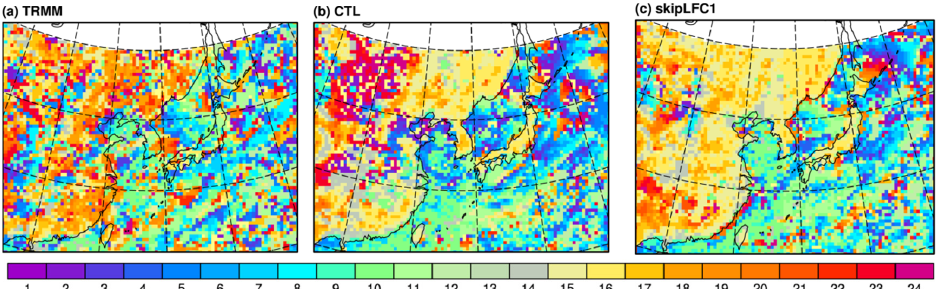
Figure 8. Spatial distribution of LST of daily maximum precipitation rate over East Asia averaged for JJA 2006 from the ( a ) TMPA observation, ( b ) CTL experiment, and ( c ) skipLFC1 experiment. The blue colors represent morning peaks, and the yellow to orange colors represent afternoon peaks.